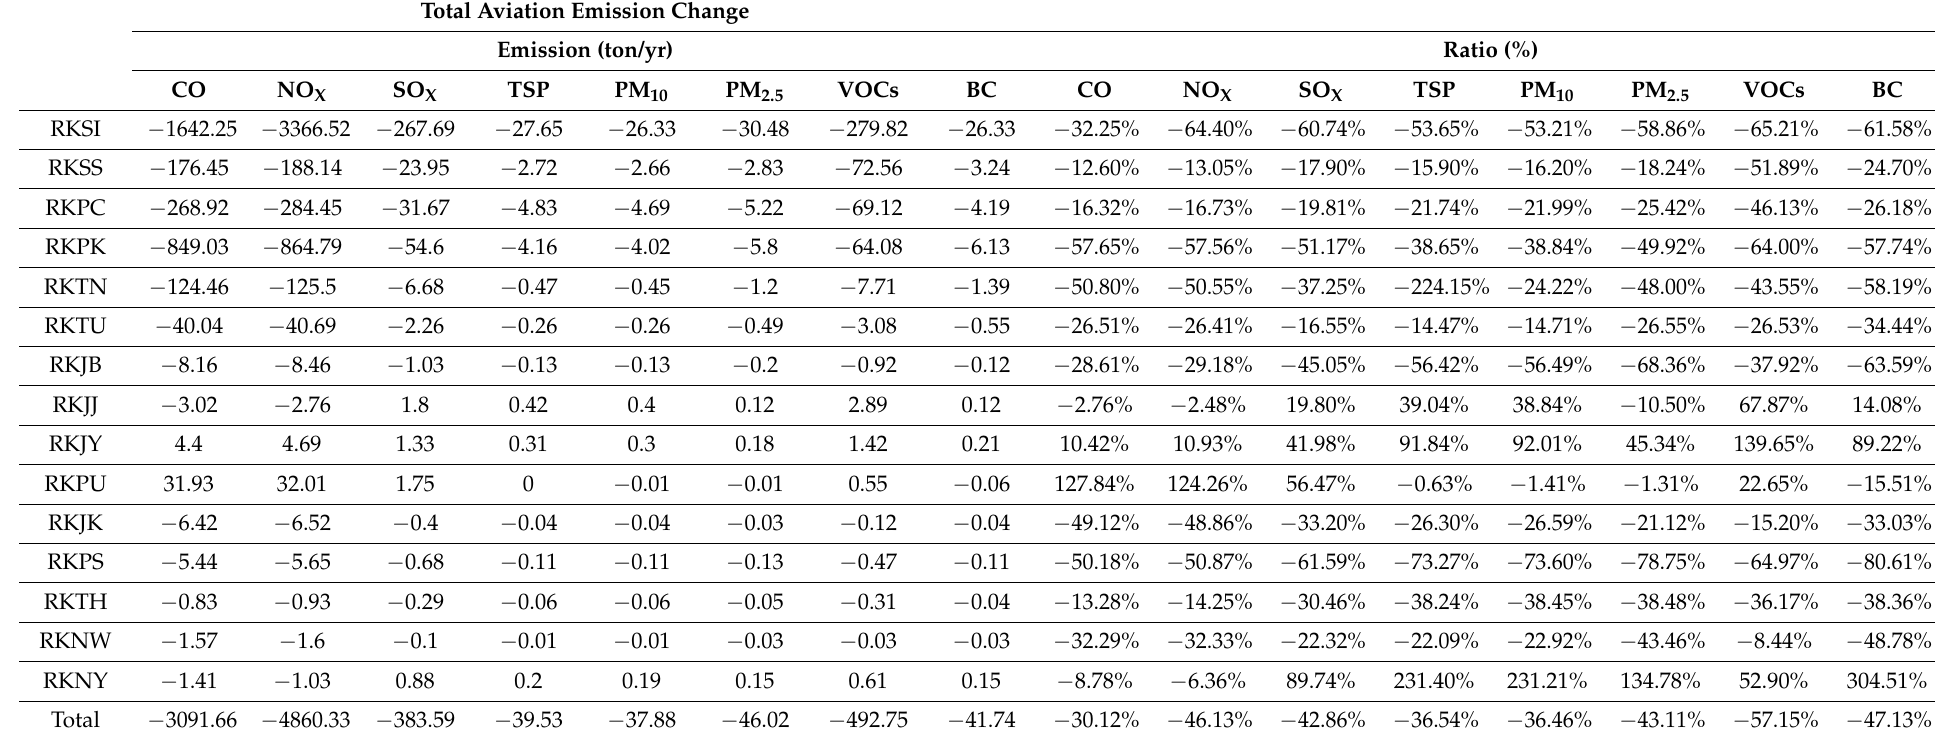
Table 5. Emissions Change due to COVID-19 in Total Aviation